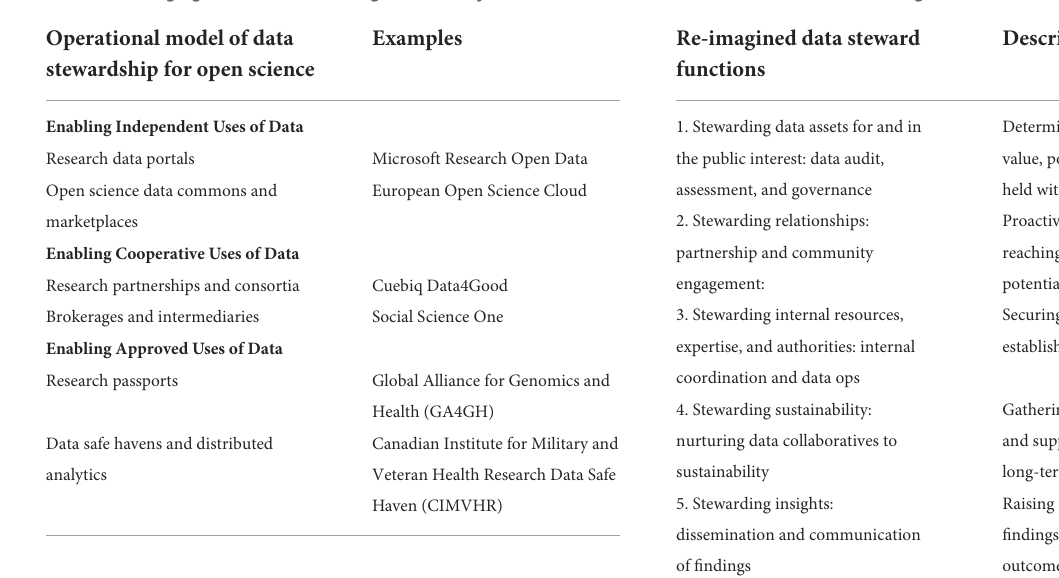
TABLE 2 Emerging models of addressing B2S data asymmetries. TABLE 3 Functions of re-imagined data